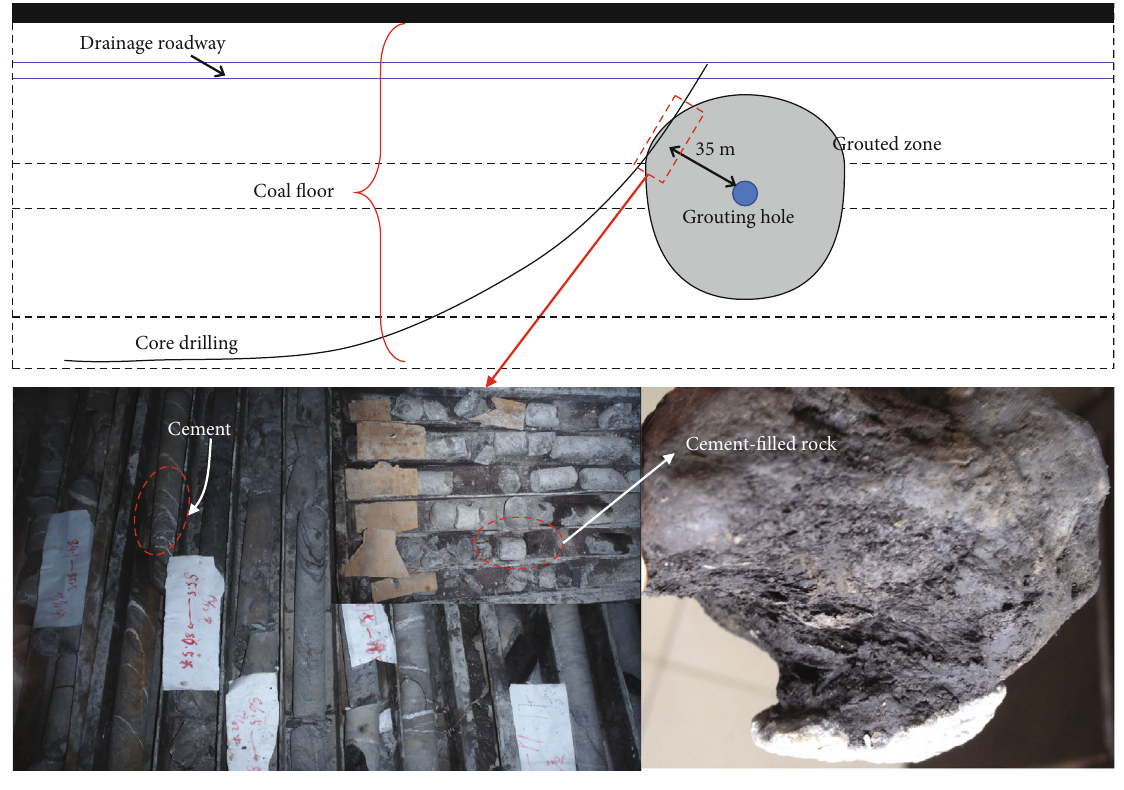
Figure 12: Core veri fi cation of grouting area in site. Table 1: Simulation parameters and